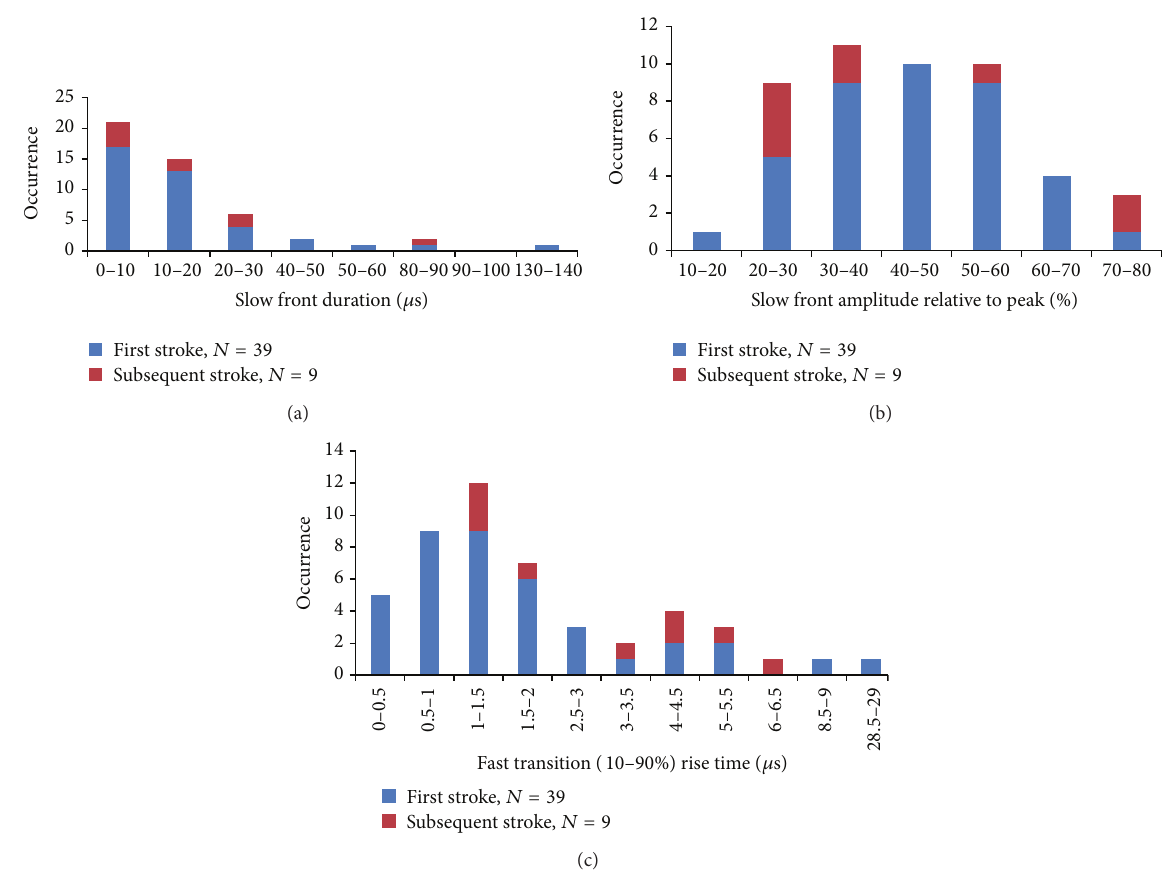
Figure 9: Histograms of (a) slow front duration, (b) slow front amplitude relative to peak, and (c) fast transition rise time (10–90%).